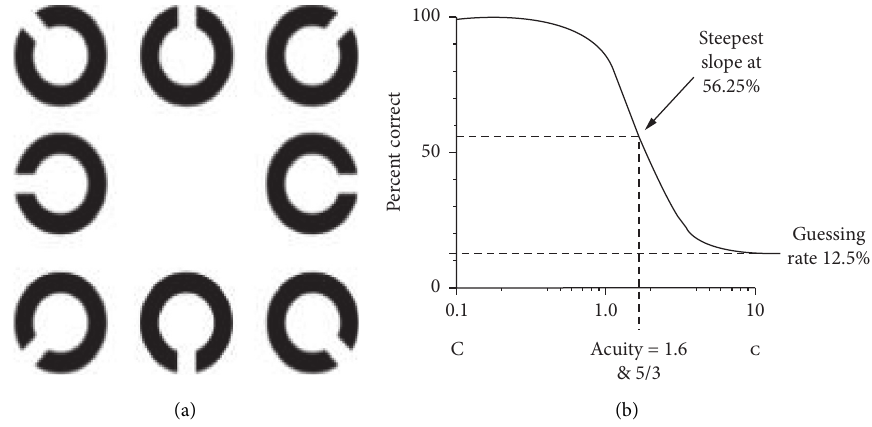
Figure 1: (a) Landolt rings displayed during the visual acuity test. 8 orientations were possible: left, top left, top, top right, right, bottom right, bottom, and bottom left. (b) Psychometric function used by the Freiburg test. The probability of correct answers depends on the size of the optotype. Visual acuity is 16/10 ( − 0.2 logMAR) [44].